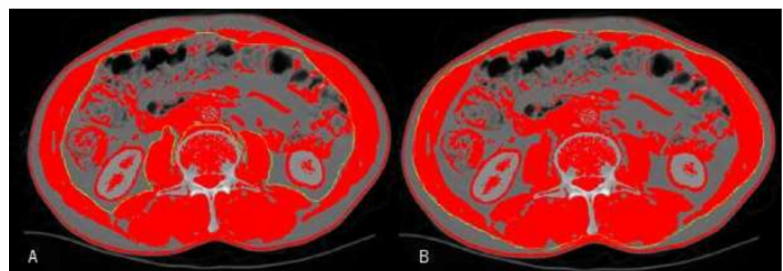
Figure 3. Cross-sectional abdominal computed tomography (CT), at L3 level, with the manual outline of the inner (Figure 1A) and external (Figure 1B) boundaries (yellow line) of muscle mass and the application of the threshold from − 29 to + 150 UH (red). Multiple muscles were identified for the measurement, including psoas muscle, erector spinae, quadratus lumborum, transversus abdominis, external and internal obliques and rectus